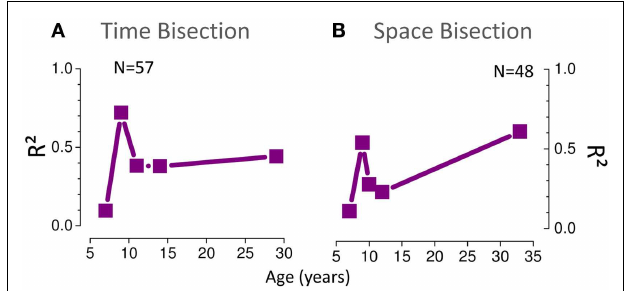
FIGURE 5 | (A) Proportion of variance ( R 2 ) of the PSE data ( Figure 3 ) for the time bisection task explained by the MLE model. A value of 1 means that all the variance was explained by the model, 0 that the model performed as well as the mean, and less than 0 that it performed worse than the mean (see Eq. 7). (B) The same for the space bisection task.